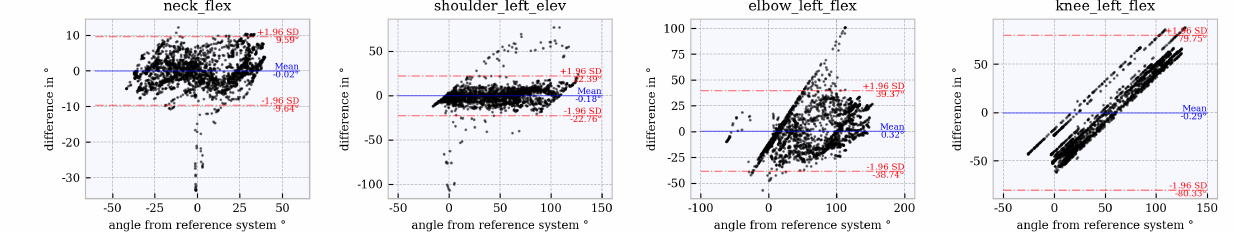
Figure 12. Bland–Altman plot for tracker configuration 3 ; x does not show the average of both systems but the joint angles of the reference system, Qualisys.